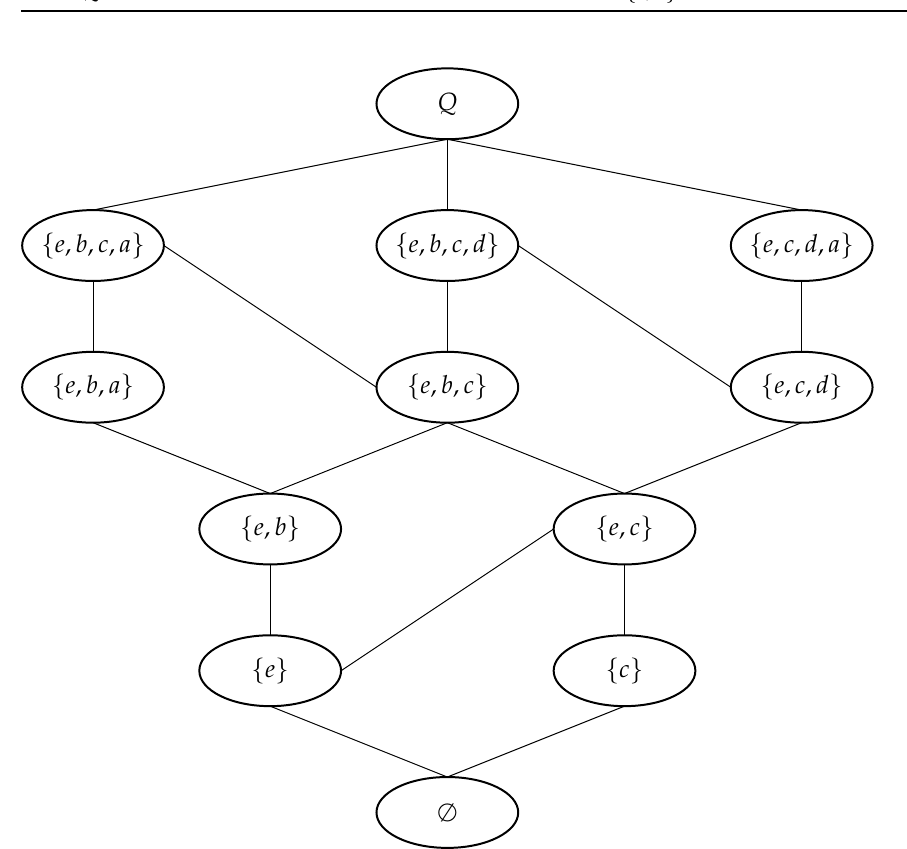
Figure 4. Learning Space ( Q , L ) with Example